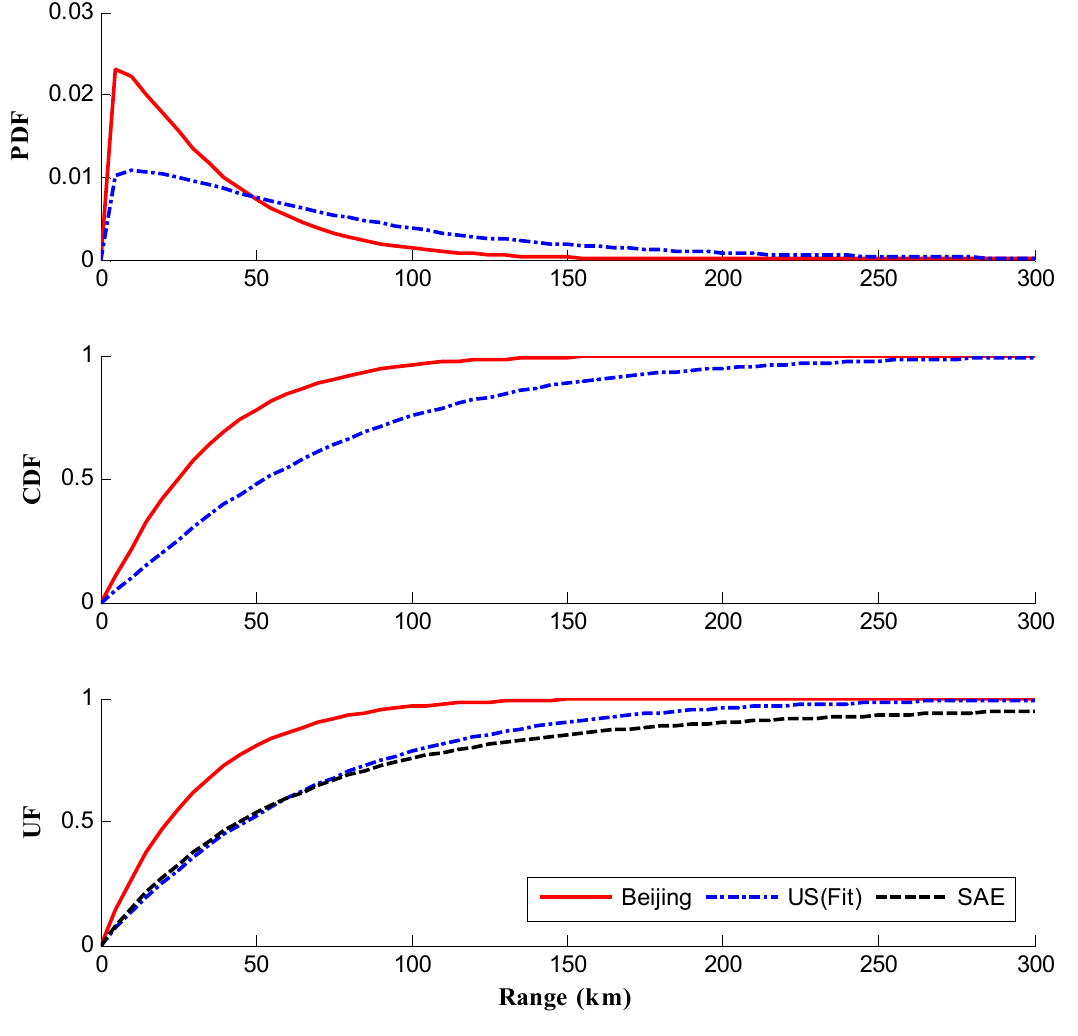
Figure 8. Daily range distribution comparison between Beijing and